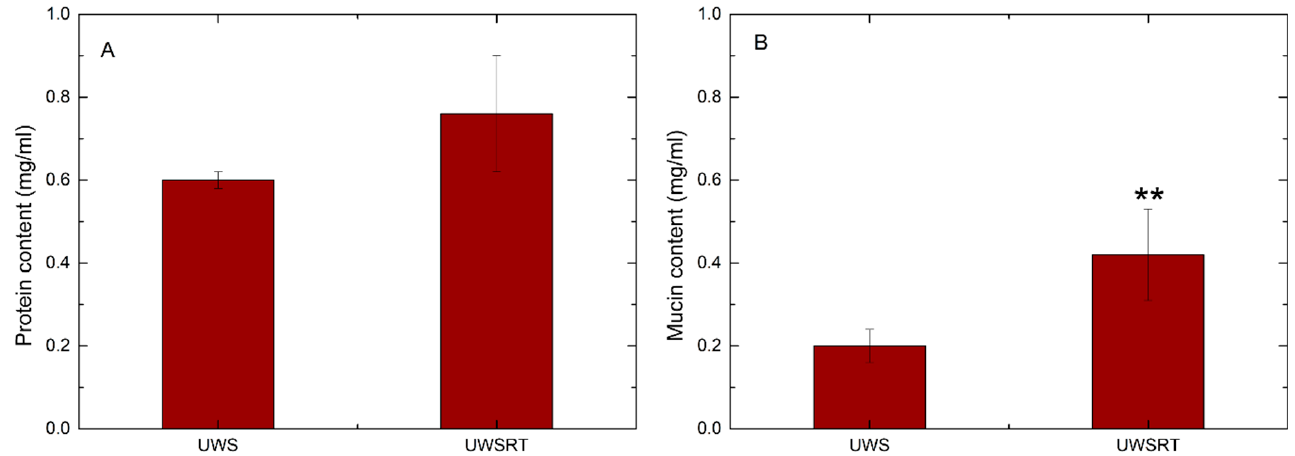
Figure 1. Comparison of the whole protein concentration ( A ) and mucin concentration ( B ) of UWS (healthy volunteers) and UWS RT (patients receiving radiotherapy). Differences were evaluated significant at a level of p < 0.01 (**).